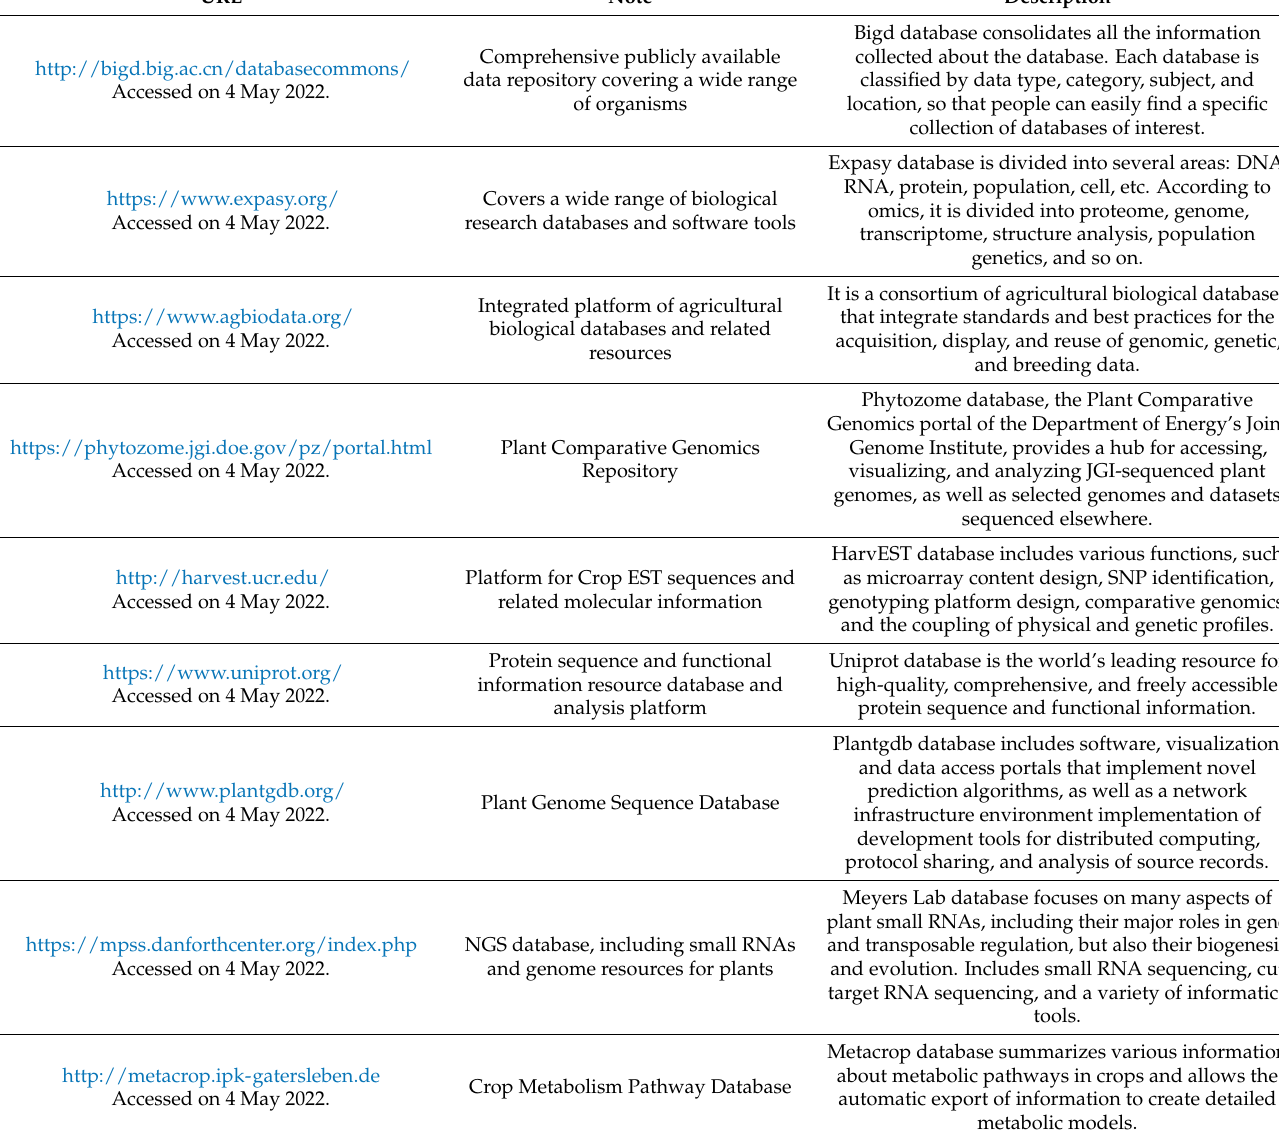
Table 1. General databases used for data integration and